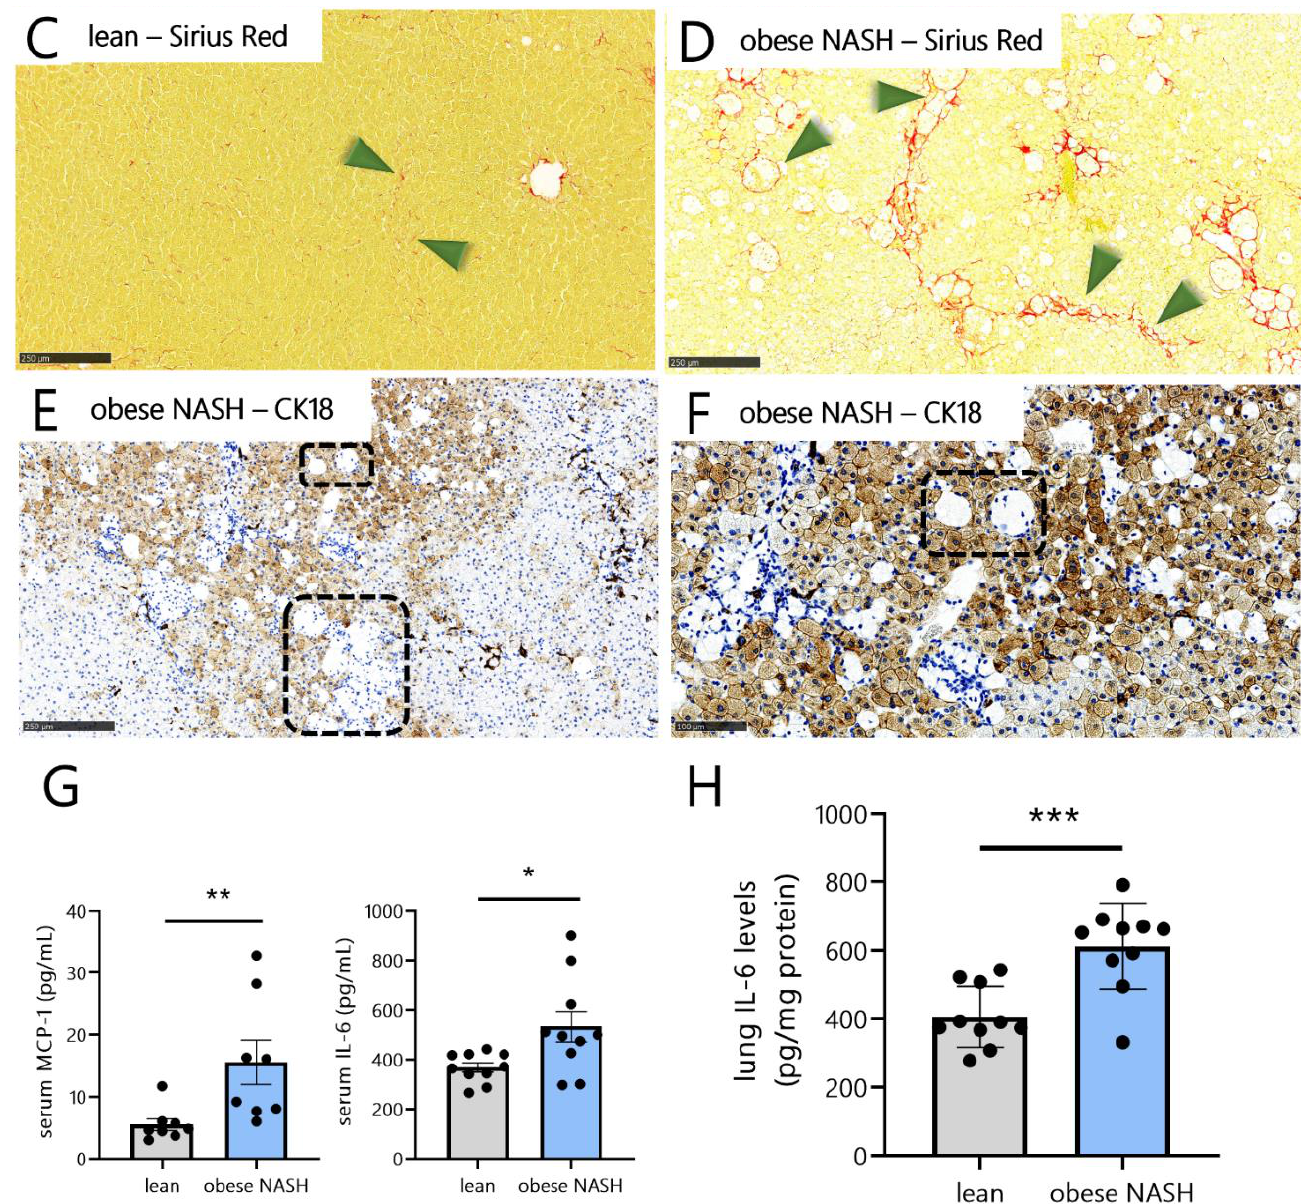
Figure 1. Free-choice-diet-induced obesity, NASH/liver fibrosis, and lung inflammation. ( A – D ) Representative liver histology images after H&E staining ( A , B ) and Sirius Red staining ( C , D ) of lean hamsters ( A , C ) and obese NASH hamsters ( B , D ), respectively. Blue dashed squares indicate inflammatory foci and hepatocyte ballooning, and green arrows indicate liver fibrosis. ( E ) Cytokeratin-18 (CK18) immunostaining of liver samples from obese NASH hamsters. Black dashed squares indicate clusters of ballooned hepatocytes lacking cytokeratin-18. ( F ) Hepatocyte ballooning is shown at a higher magnification. ( G ) Serum levels of MCP-1 and IL-6 and ( H ) lung levels of IL-6 protein in lean hamsters and obese NASH hamsters. Data are shown as the mean ± SD ( n = 10 animals per group). Significant differences were determined using an unpaired, two-tailed Student’s t -test or a Mann–Whitney U test (* p < 0.05; ** p < 0.01; *** p < 0.001). Scale bars: 250 µm ( A – F ) .